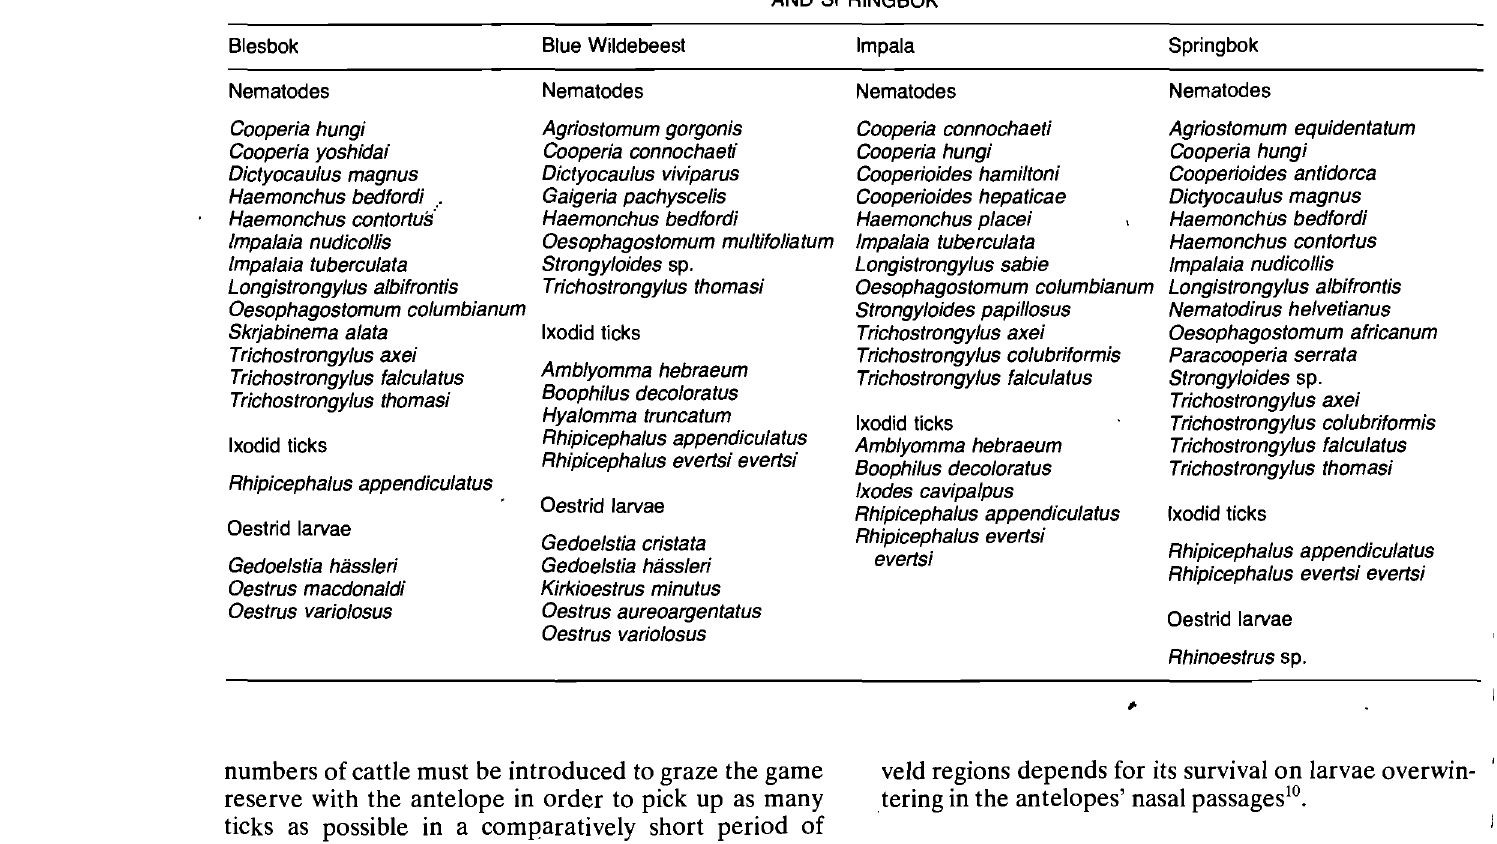
Table 1: NEMATODES. IXODID TICKS AND OESTRID FLY LARVAE RECOVERED FROM BLESBOK, BLUE WILDEBEEST, IMPALA Blesbok